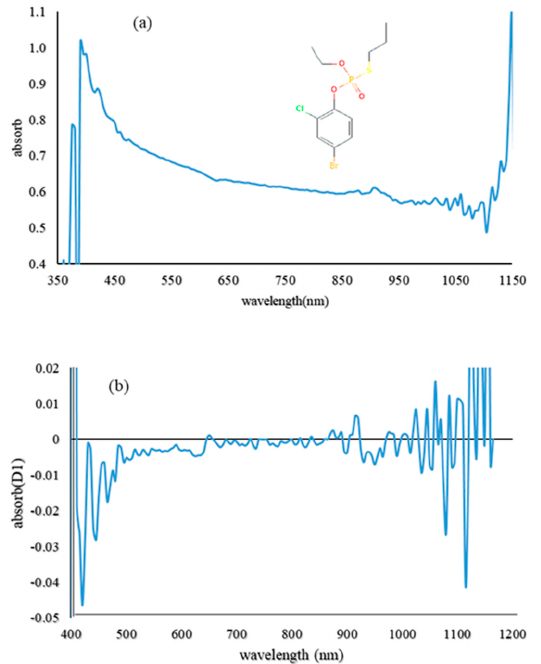
Figure 4. Absorption spectrum of pure profenofos pesticide ( a ) and its first derivative ( b ).